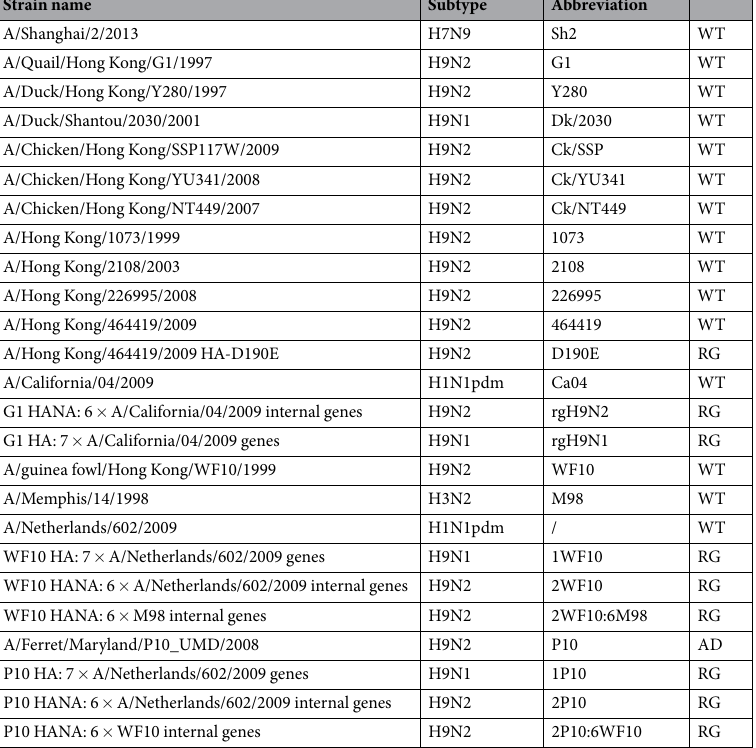
Table 1. List of viruses used and discussed in this study, including their abbreviation. Key: WT, wild type; RG, reverse genetic constructed; AD,